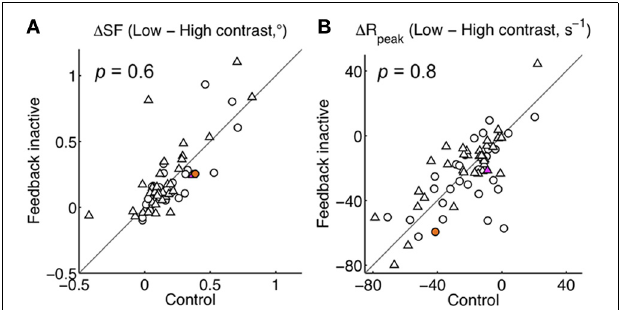
contrast ( (cid:3) SF) plotted per unit for Feedback inactive vs. Control conditions. (B) Corresponding shift in the peak response rate ( (cid:3) R peak ). For both panels p -values correspond to a two-tailed t -test between feedback conditions. The magenta and orange symbols indicate shifts for the example units in Figure 1 . No systematic change in contrast-induced effects were detected when feedback was inactivated.